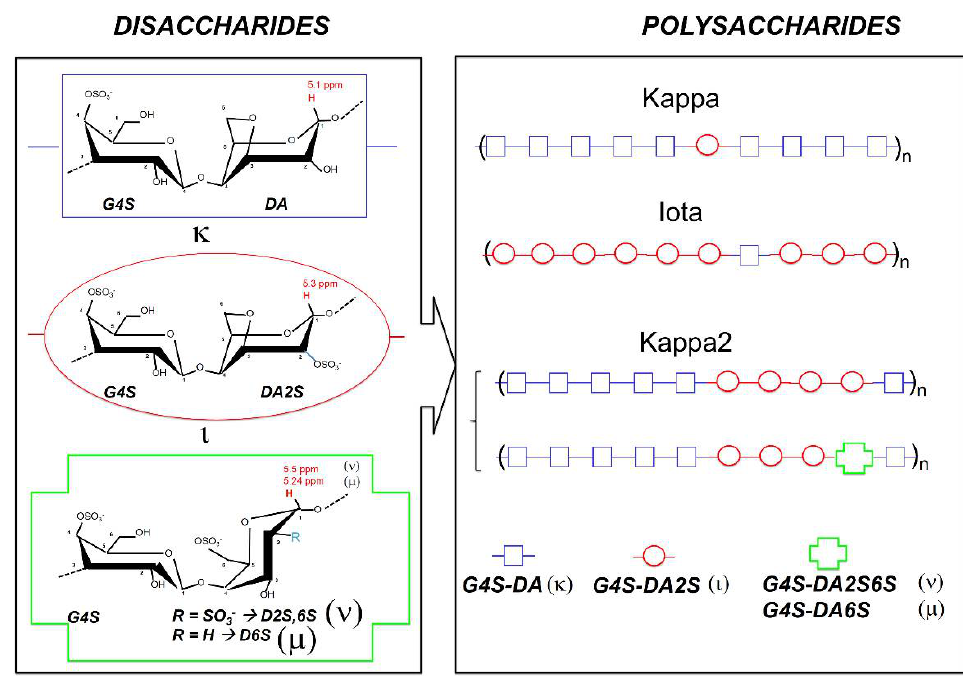
Figure 1. Chemical structures of industrially relevant gelling carrageenans.